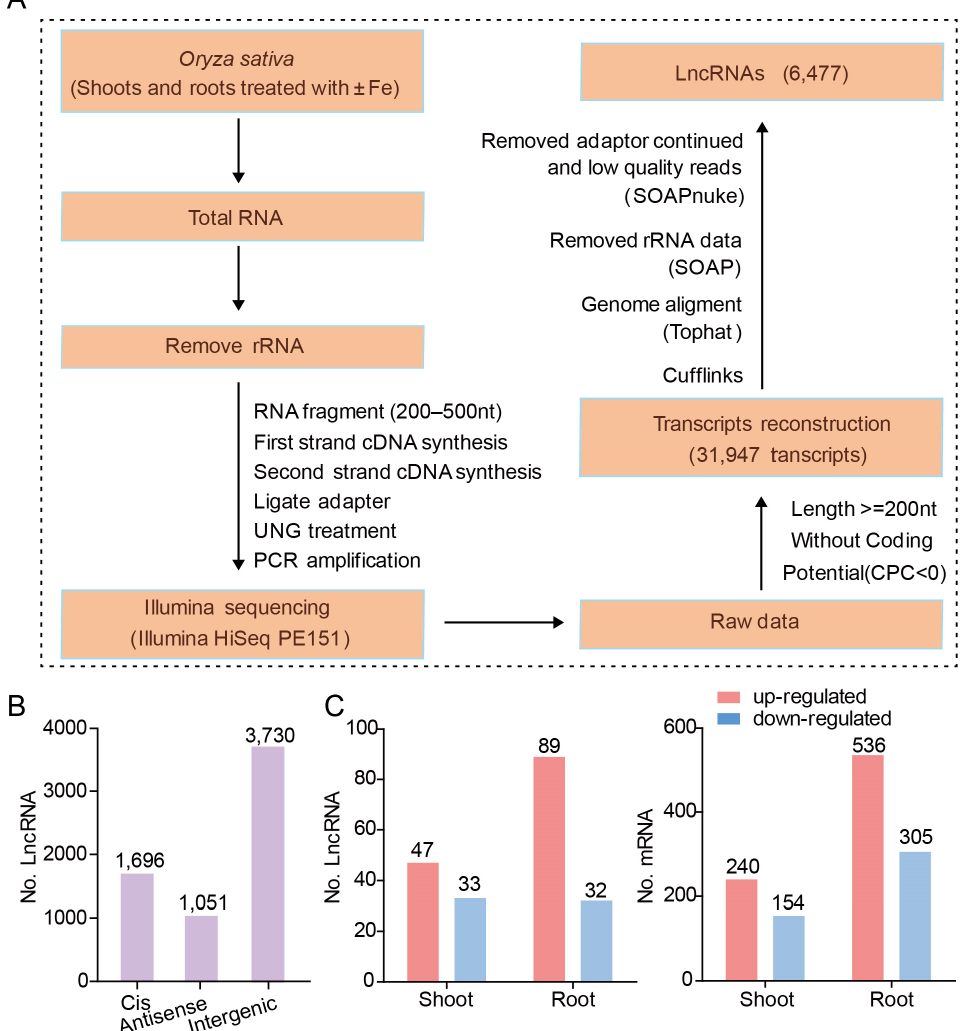
Figure 2. Identification and characterization of lncRNAs. ( A ) The pipeline for identification and characterization of known and novel lncRNAs responding to iron deficiency by ssRNA-seq (see methods). ( B ) Location of lncRNAs relative to the nearest protein-coding genes. LncRNAs were categorized according to the position relative to neighboring coding genes. The lncRNAs located at the antisense strand of coding transcripts were defined as antisense lncRNA. Other lncRNAs without overlap with coding transcripts were classified as intergenic lncRNAs, cis-lncRNAs were close ( ≤ 500 nt) and on the sense strand with the adjacent genes. ( C ) Total number of differentially expressed lncRNAs and mRNAs. The number of up-regulated (Log 2 (fold change) >1; fragments per kilobase of exon per million fragments mapped (FPKM) > 2; probability > 0.8) and down-regulated (Log 2 (fold change) < − 1; FPKM > 2; probability > 0.8) lncRNAs and mRNAs in response to Fe deficiency in shoot and root.